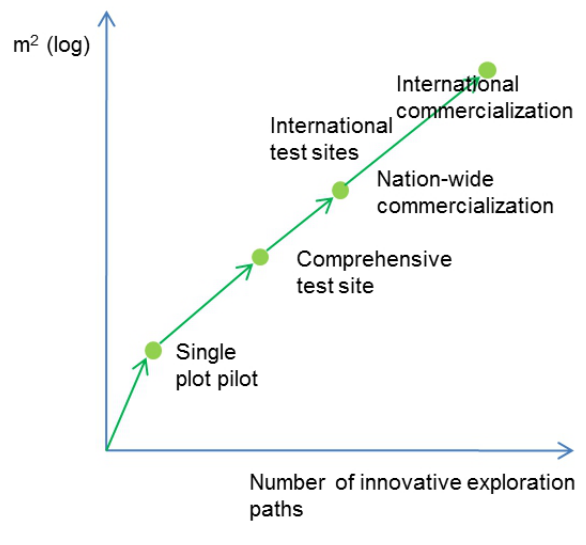
Fig. 3 . The number of innovation paths that could be taken, set against logarithmic physical